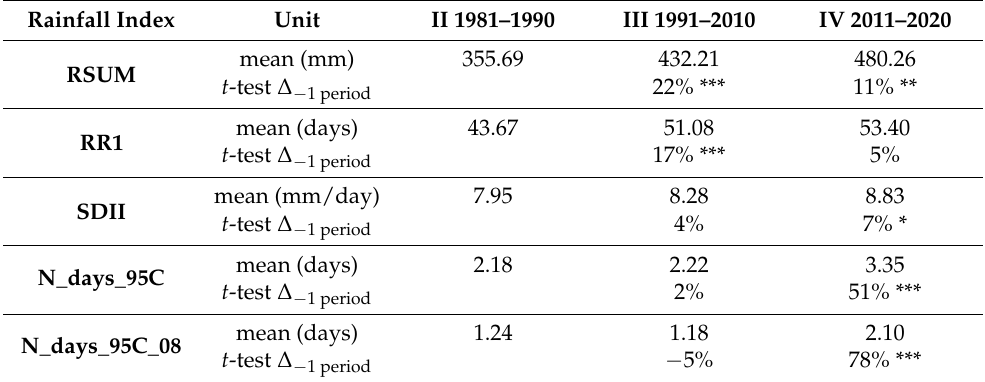
distributed variables, the Wilcoxon–Mann–Whitney test (U-test) is showed. Significance of